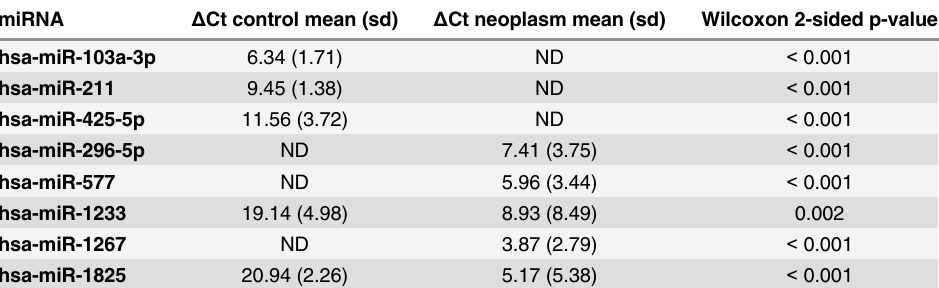
Table 2. Mean Δ Ct (sd) and Wilcoxon 2-sided p-values of discovered salivary miRNA biomarkers. The discovery sample set consisted of whole saliva samples from patients with a parotid gland neoplasm (n = 20) and whole saliva samples from healthy controls (n =